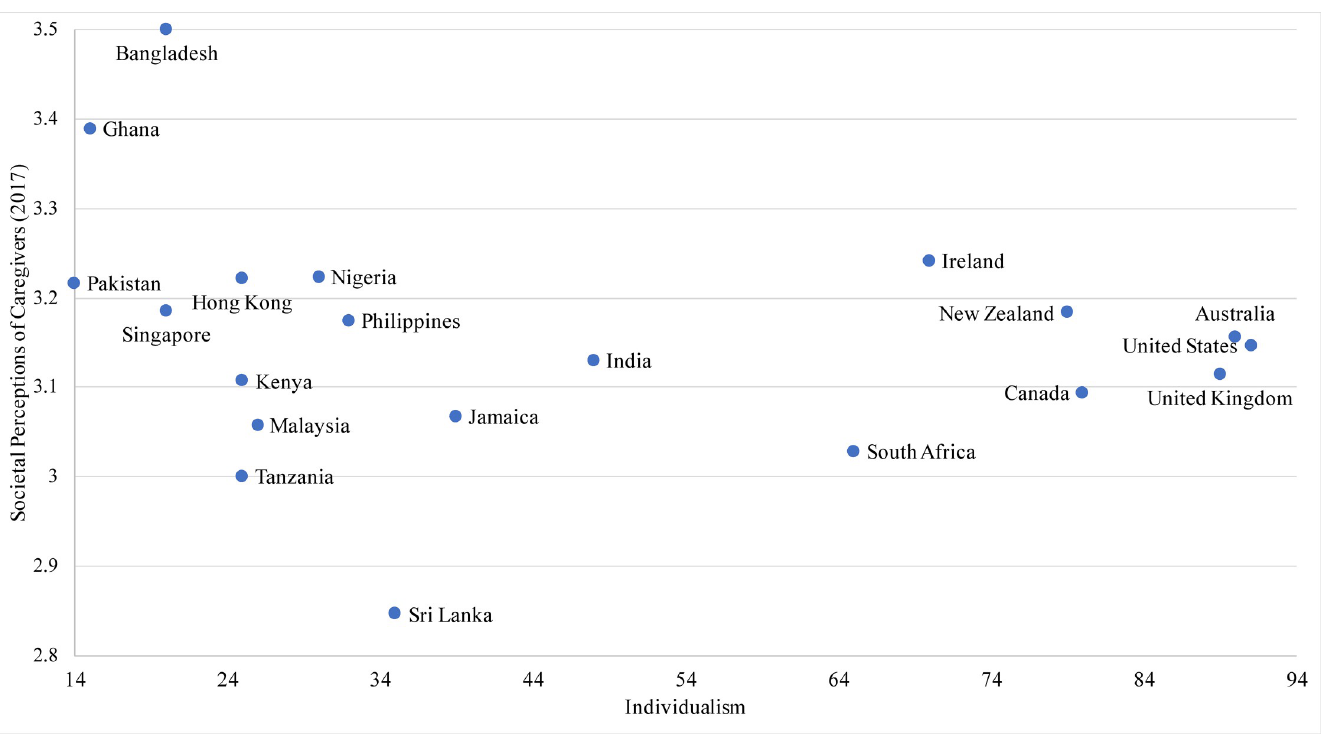
Fig 3. Scatterplot of societal perceptions of caregiving and individualism across 20